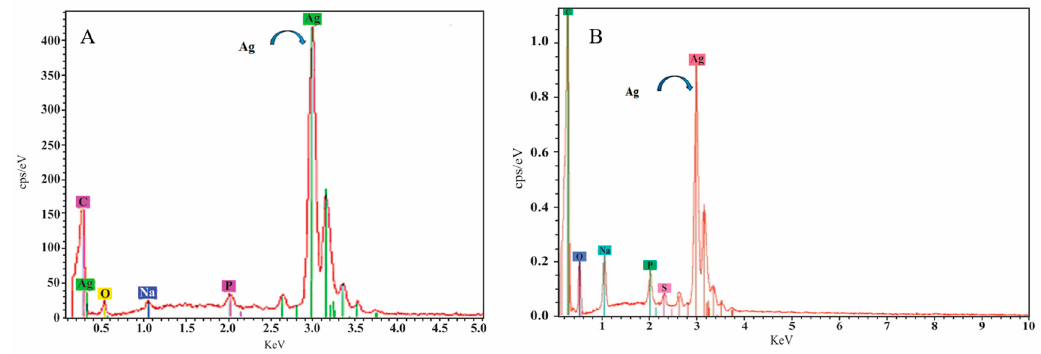
Figure 4. Elemental analysis of spherical nanoparticles ( A ) and prismatic nanoparticles ( B ) performed by energy dispersive X-ray spectroscopy (EDX), confirming elemental silver composition.